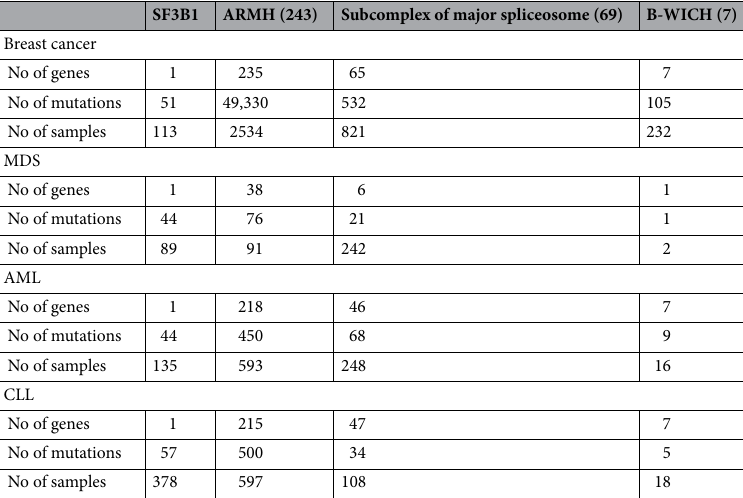
Table 4. The association between each of the four diseases and SF3B1 or its family separately based on COSMIC